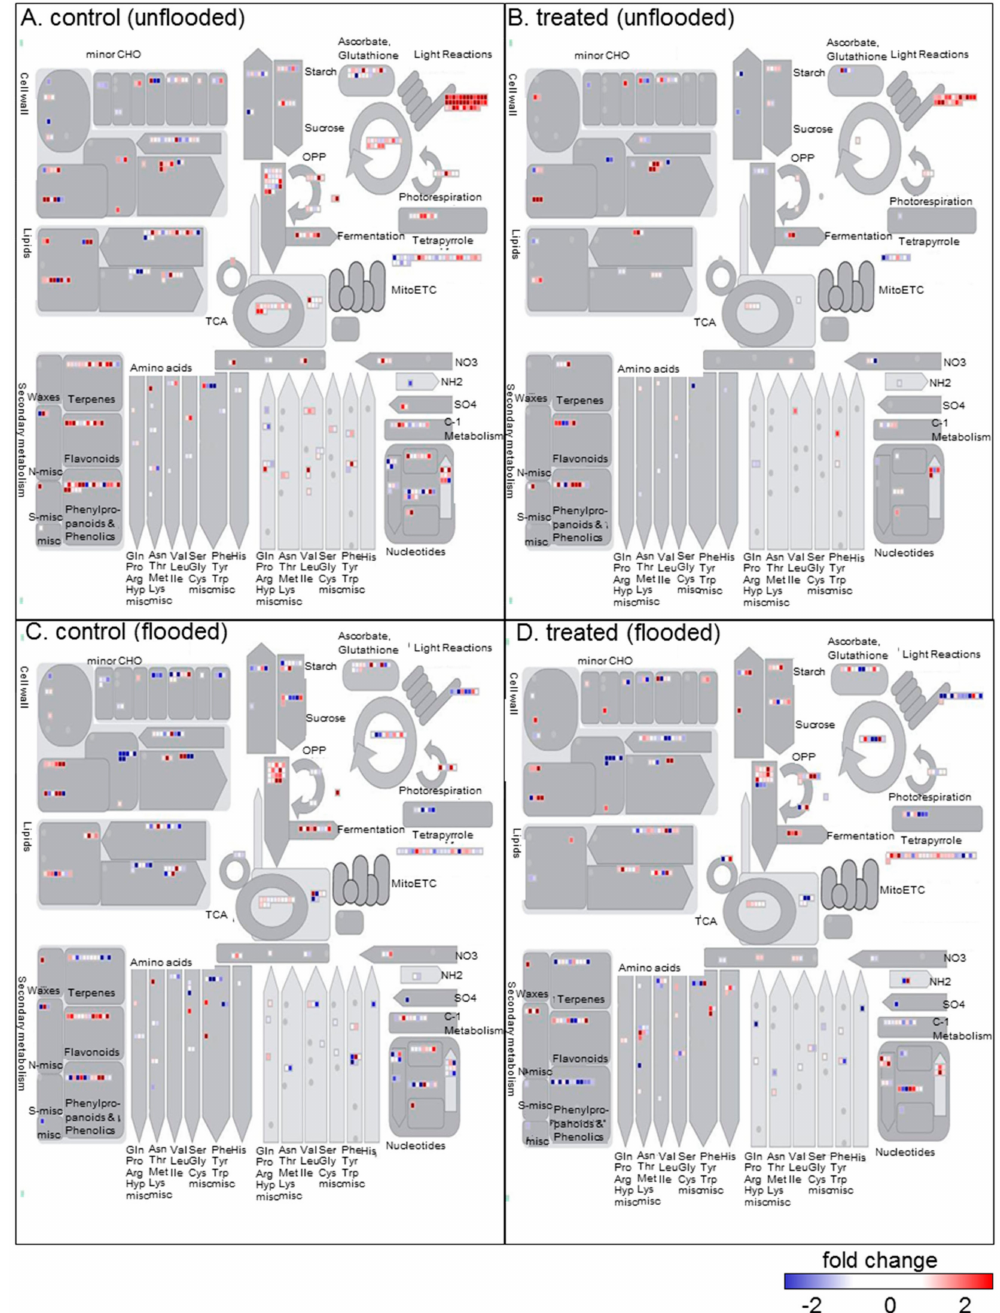
Figure 3. Mapping on metabolic pathways of di ff erentially changed proteins identified from soybean seedling irradiated without (control) or with millimeter waves (treated) under flooded or unflooded conditions. ( A ) Mapping from unirradiated soybean under unflooded conditions. ( B ) Mapping from irradiated soybean under unflooded conditions. ( C ) Mapping from unirradiated soybean under flooding. ( D ) Mapping from irradiated soybean under flooding. Changed proteins were submitted to the MapMan software and mapped to metabolic pathways. Each square indicates one mapped protein. Color indicates the fold change value of a di ff erentially changed protein. Red and blue colors indicate an increase and decrease in fold change values, respectively. Abbreviations: CHO, carbohydrate metabolism; MitoETC, mitochondrial electron transport chain; misc, miscellaneous; OPP, oxidative pentose phosphate pathway; TCA, tricarboxylic acid